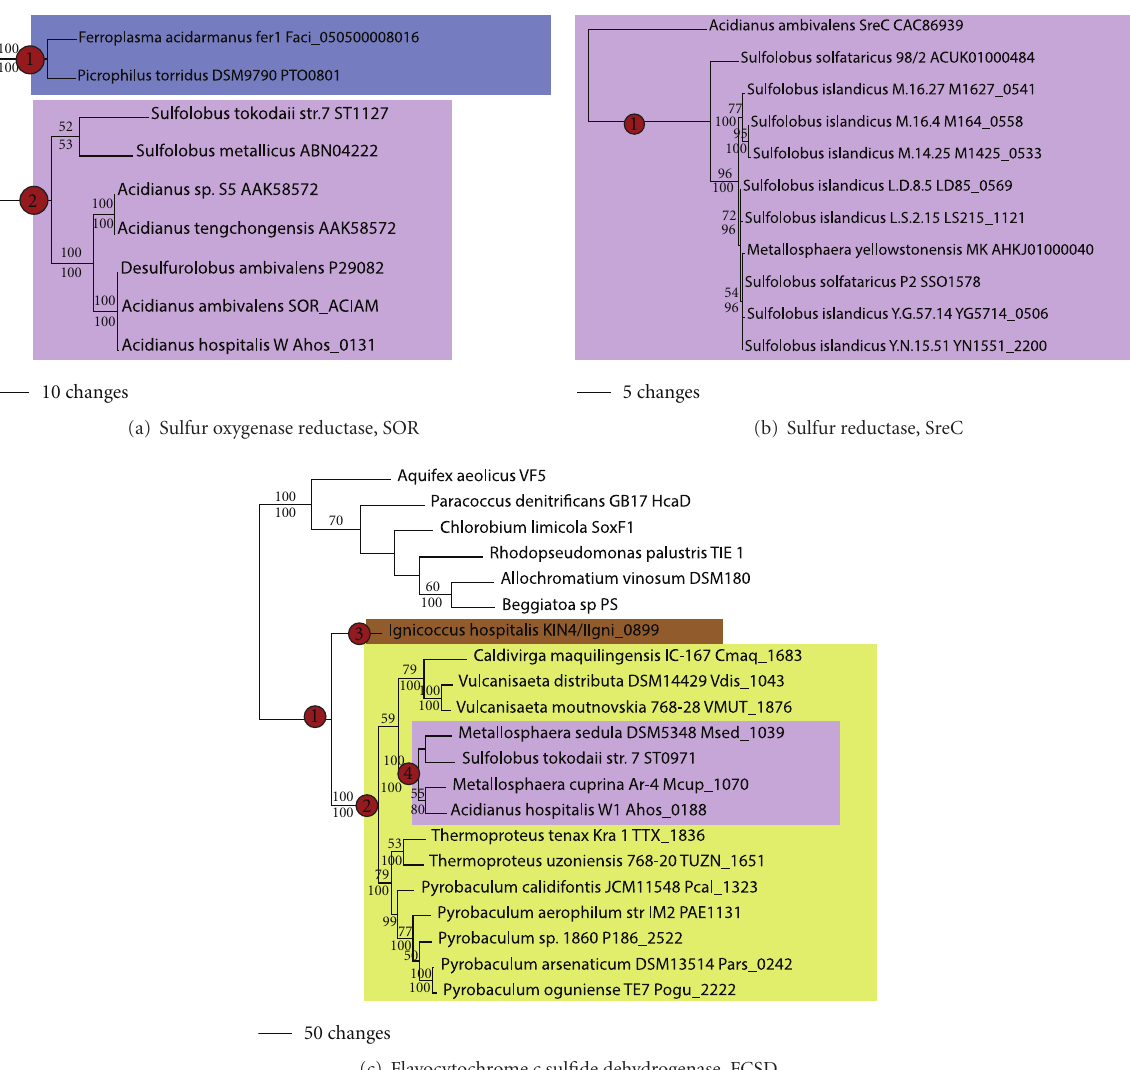
Figure 8: Sulfur oxidation and reduction. Phylogenetic trees for (a) SOR sulfur oxygenase reductase, (b) SreC sulfur reductase, and (c) FCSD flavocytochrome c sulfide